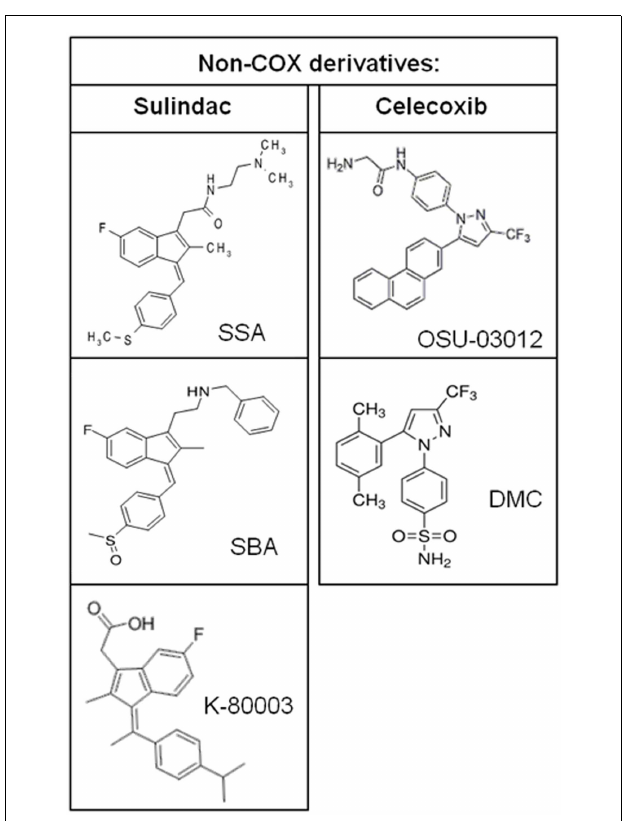
FIGURE 5 | Chemical structures of non-COX-inhibitory derivatives of sulindac and celecoxib .